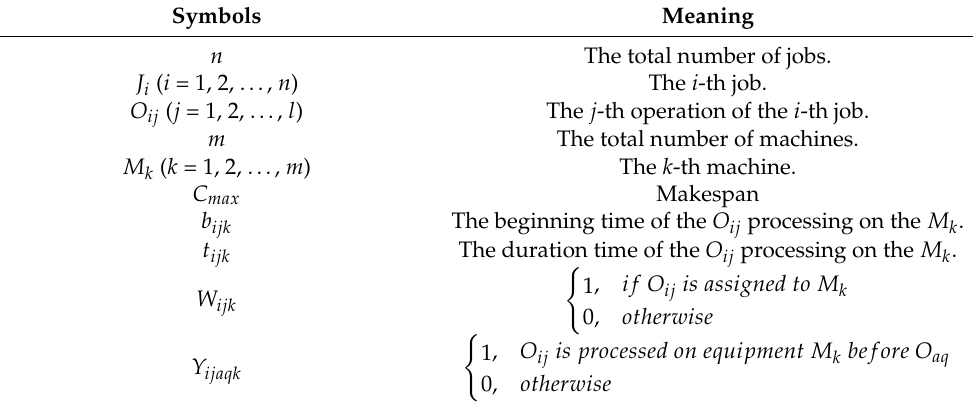
Table 1. The symbols of FJSP.